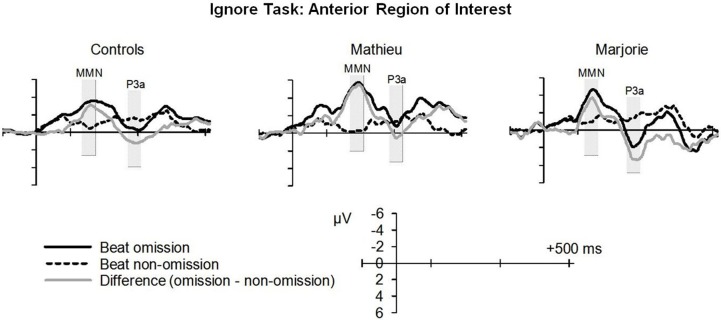
“Ignore” task: MMN and P3a. Grand averaged event-related potentials (ERPs) elicited by deviant beat omissions and corresponding standard target beats in the ignore task for the control participants (left column), Mathieu (middle column), and Marjorie (right column). Activity within the anterior region of interest is shown (see Materials and Methods section for details). Shaded regions depict MMN and P3a mean amplitude analysis time windows. Negative is plotted upward.